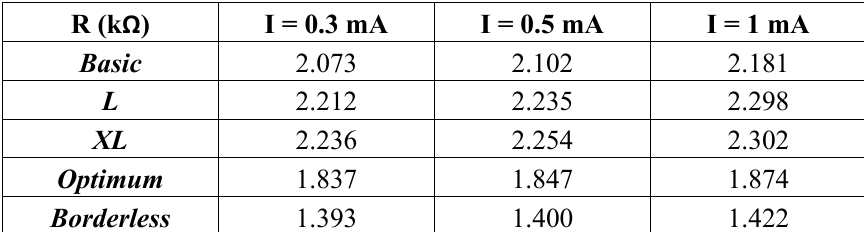
Table 2. Simulated Hall Effect devices